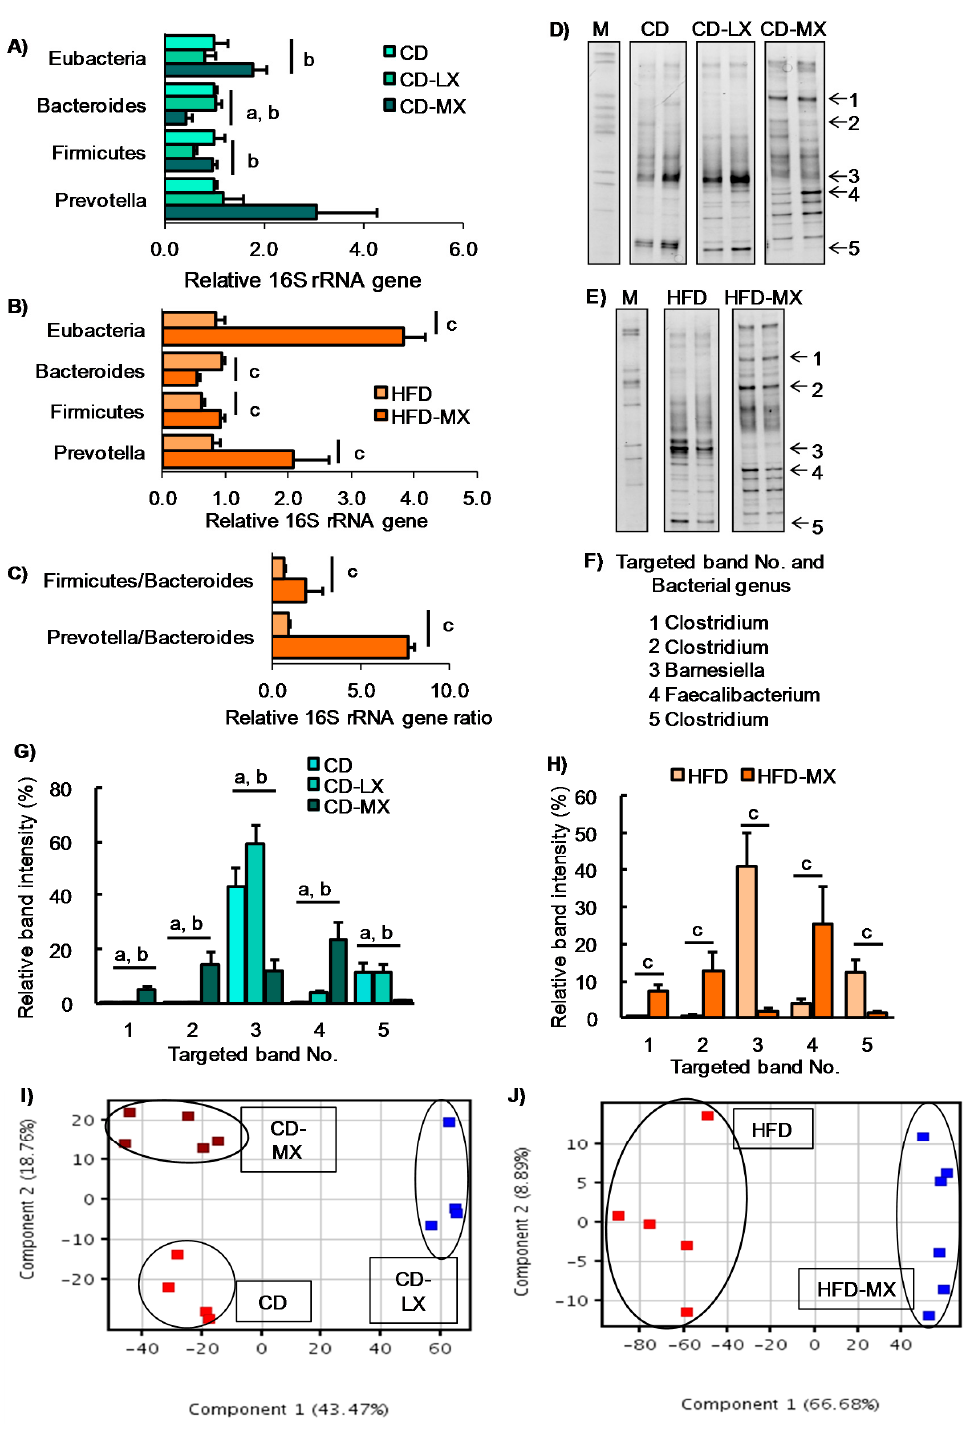
Figure 2. Changes in the fecal microbiota of mice fed xylitol. An abundance of specific bacterial phylum or genus and ratio after seven weeks of xylitol supplementation using specific primer set (Table 1) ( A – C ). Band image of DGGE analysis of DNA from feces after seven weeks of xylitol exposure with CD ( D ) or HFD ( E ). Identified five bacterial genus (No. 1–5) from DGGE band ( F ). Relative band density of identified five bacterial genus from feces after seven weeks of xylitol exposure with CD ( G ) or HFD ( H ). Two-dimensional principal component analysis plot of DGGE band pattern in mice fed xylitol with CD ( I ) or HFD ( J ). Data represent the mean ± SEM ( n = 5–6). a: p < 0.05 between CD and CD-MX. b: p < 0.05 between CD-LX and CD-MX. c: p < 0.05 between HFD and